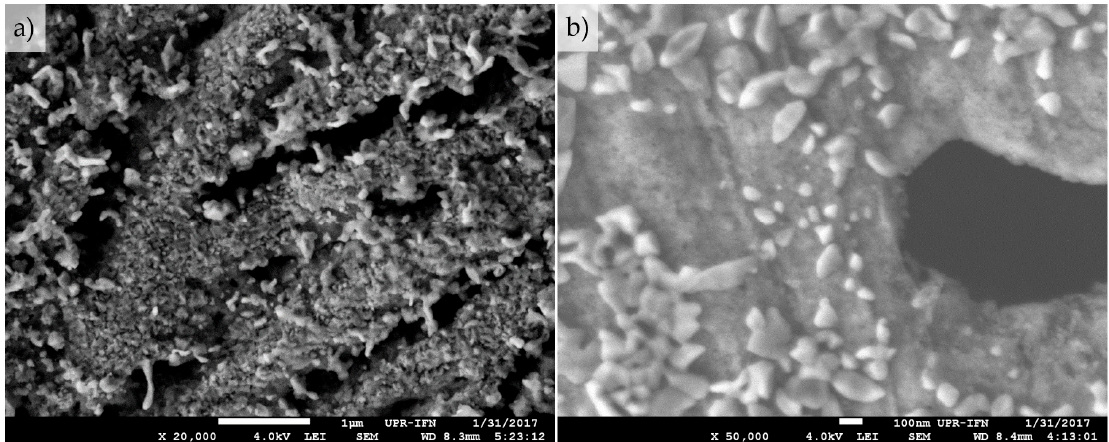
Figure 13. SEM image of ( a ) EC sample with aluminum oxide formation due to incorrect treatment after corrosion and; ( b ) SEM image with more magnification than ( a ).